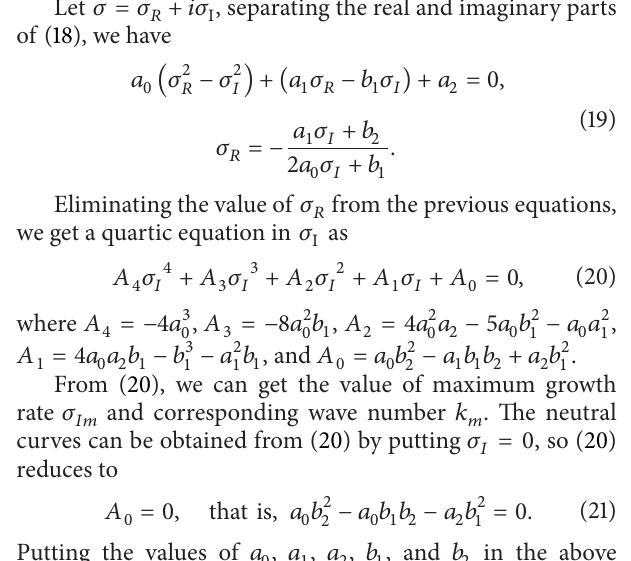
Figure 1: The neutral curves of Weber number for the different values of velocity ratio when 𝐸 = 1 , 𝜇 = 0.018 , 𝜌 = 0.0012